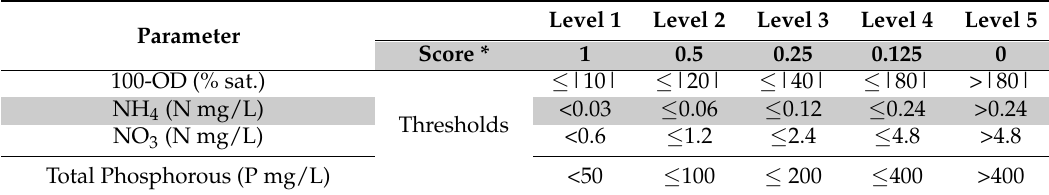
Table A4. Thresholds for score attribution to each parameter.